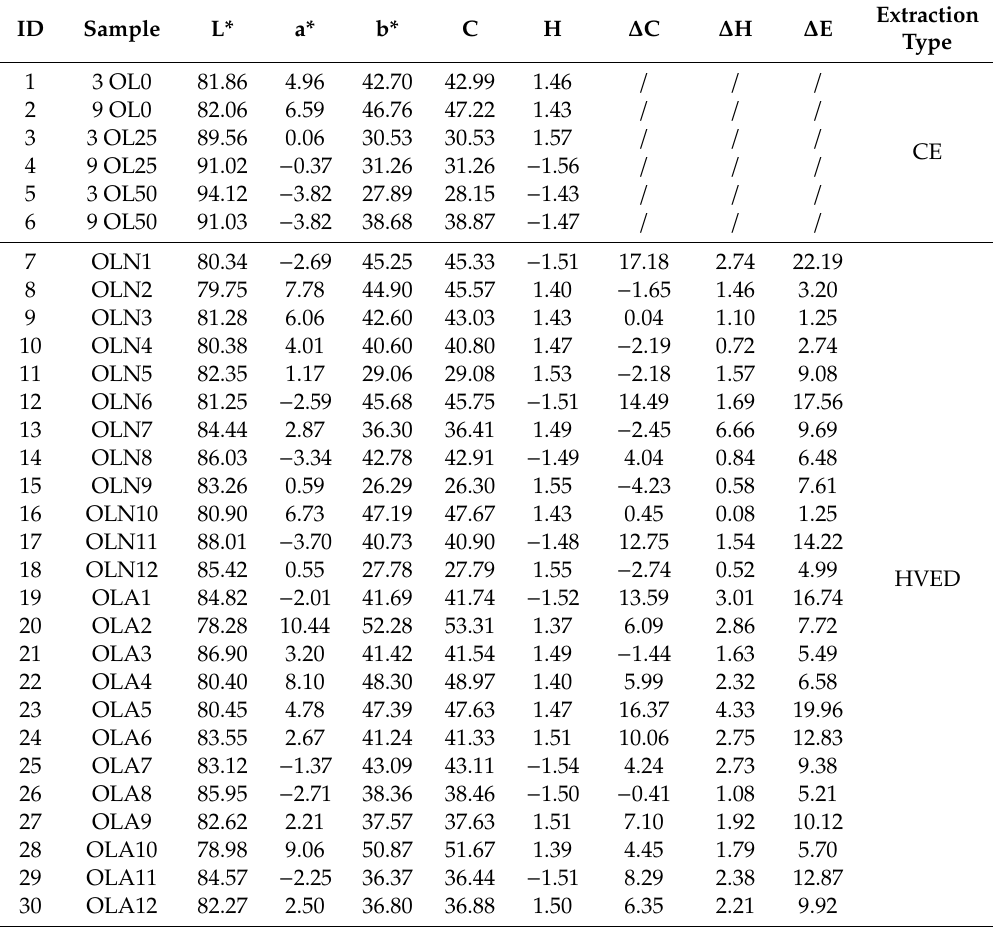
Table 5. CIELab color parameters of CE and HVED treated